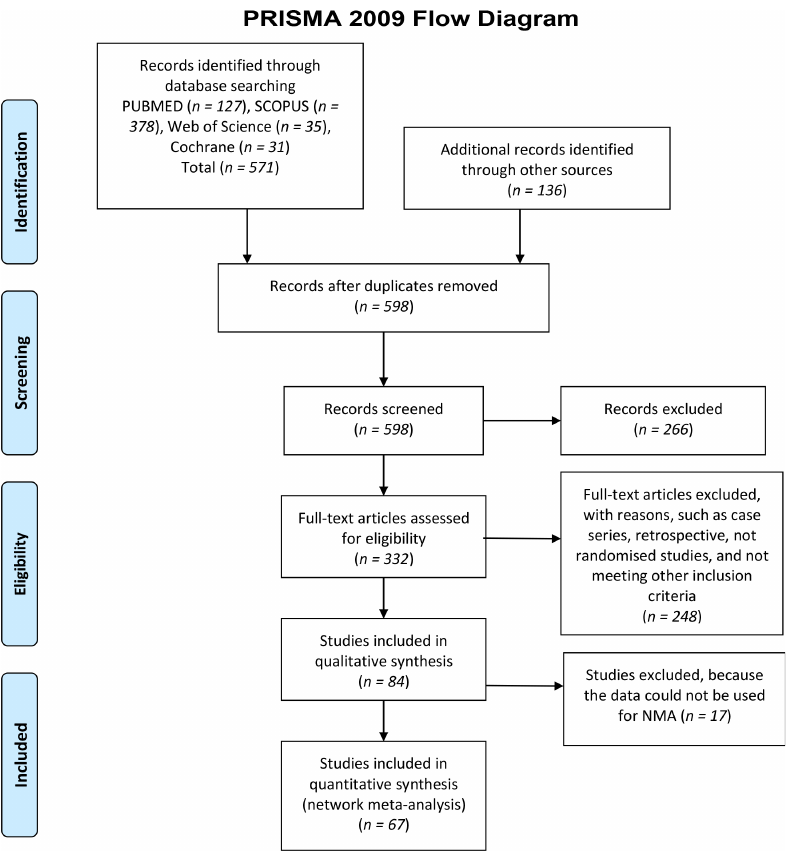
Figure 1. Study flow diagram showing the study selection process.